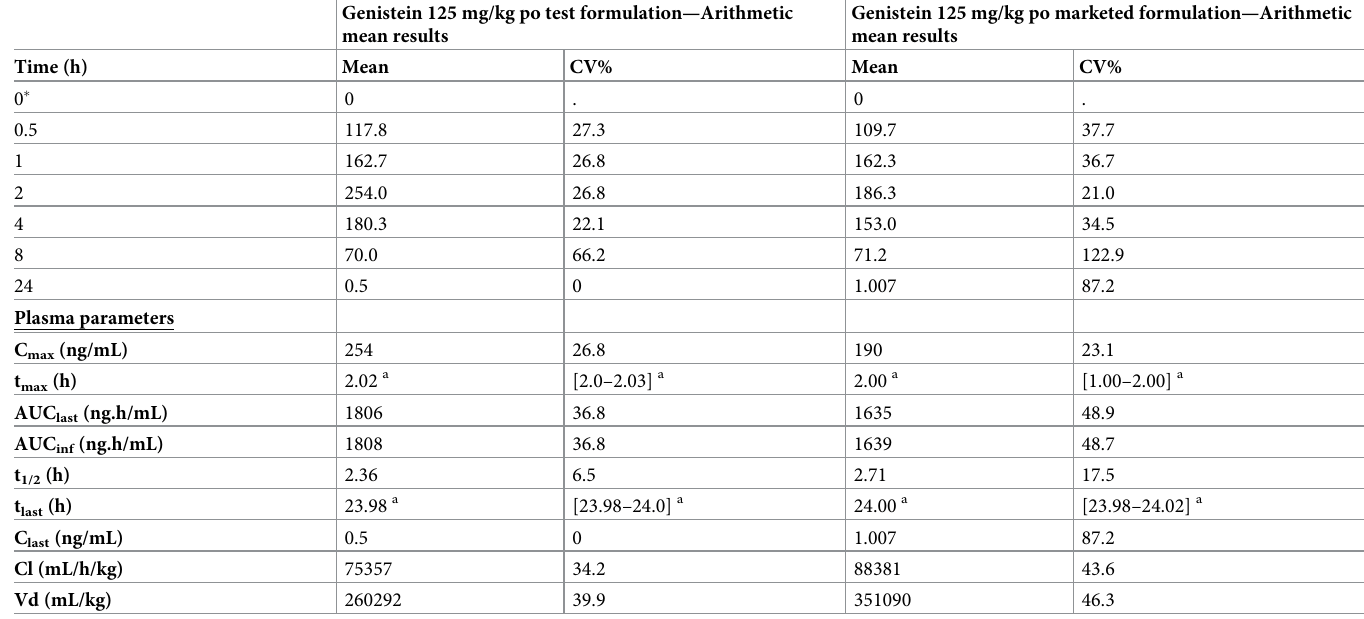
Table 10. Arithmetic mean (CV%) plasma concentration (ng/mL) of genistein after oral administration of the genistein test and marketed formulation (125 mg/kg) in male Wistar rats.